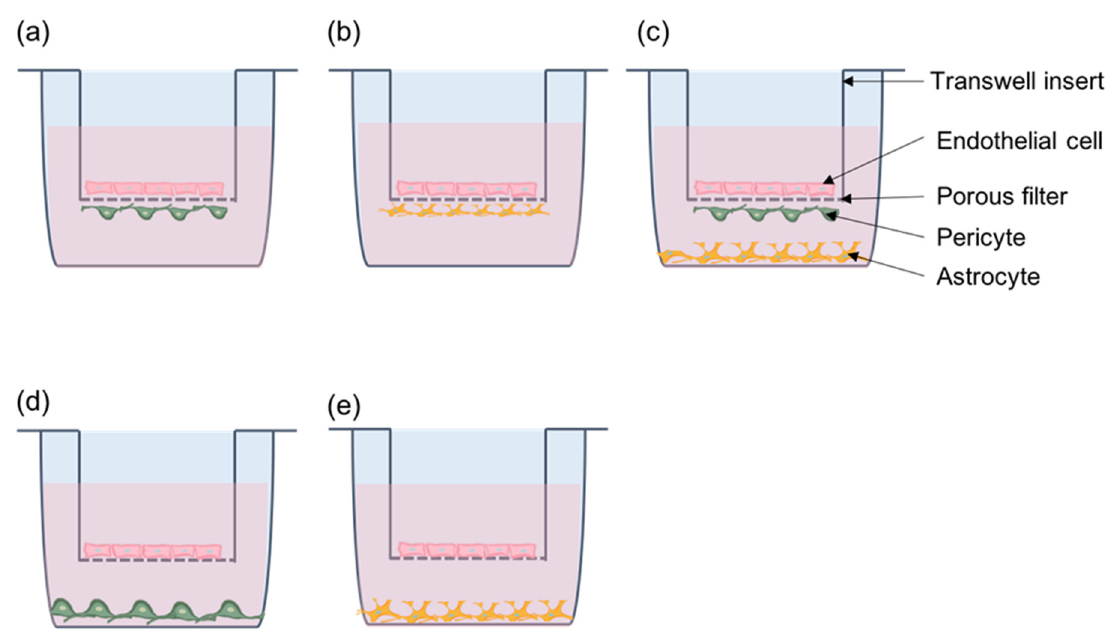
Figure 6. Transwell system for co-culture. ( a ) Direct contact model with endothelial cells and pericytes. ( b ) Direct contact model with endothelial cells and astrocytes. ( c ) Tri-cellular culture model with endothelial cells, pericytes, and astrocytes. Endothelial cells and pericytes are in contact. ( d ) Non-contact model with endothelial cells and pericytes. ( e ) Non-contact model with endothelial cells and